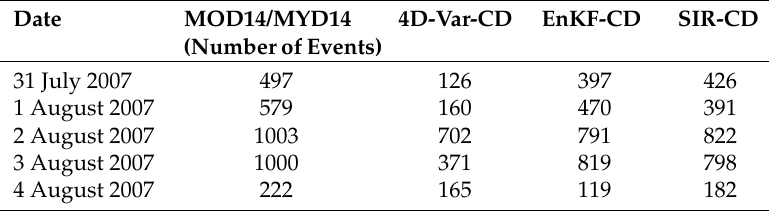
Figure 3. User’s-Producer’s plot for the case a comparison to MODIS MOD14/MYD14 is implemented considering 20 min before and after the MODIS detection. Table 3. Detection accuracy comparison against MODIS MOD14/MYD14 fire products at 10 − 3.5